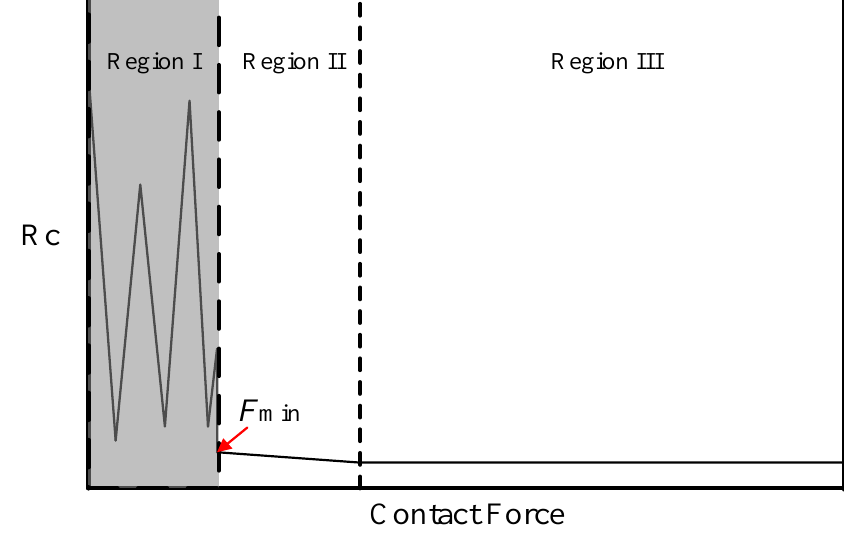
Figure 1. Schematic plot of contact resistance R making. Region I: unstable region; Region II: gradual reduction of R negligible reduction of R c